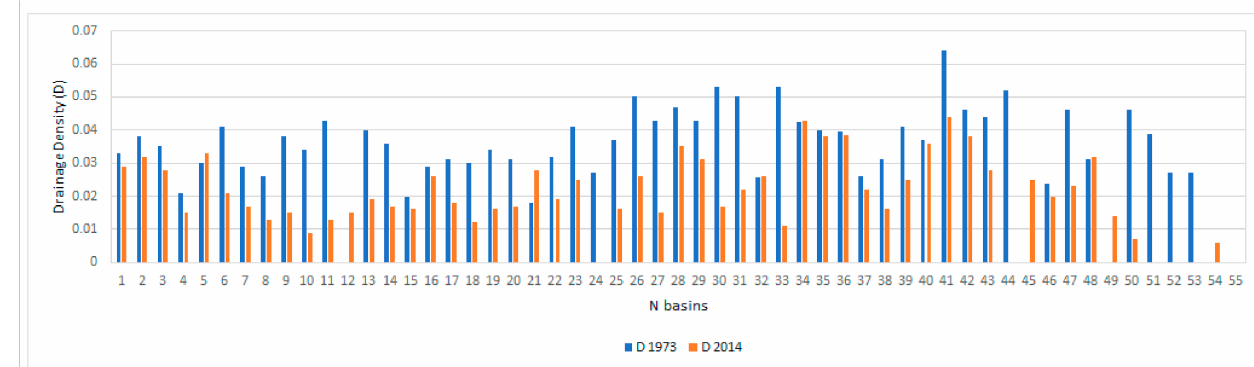
Figure 6. Variation of drainage density (D) values in 1973 (in blue) and in 2014 (in orange).